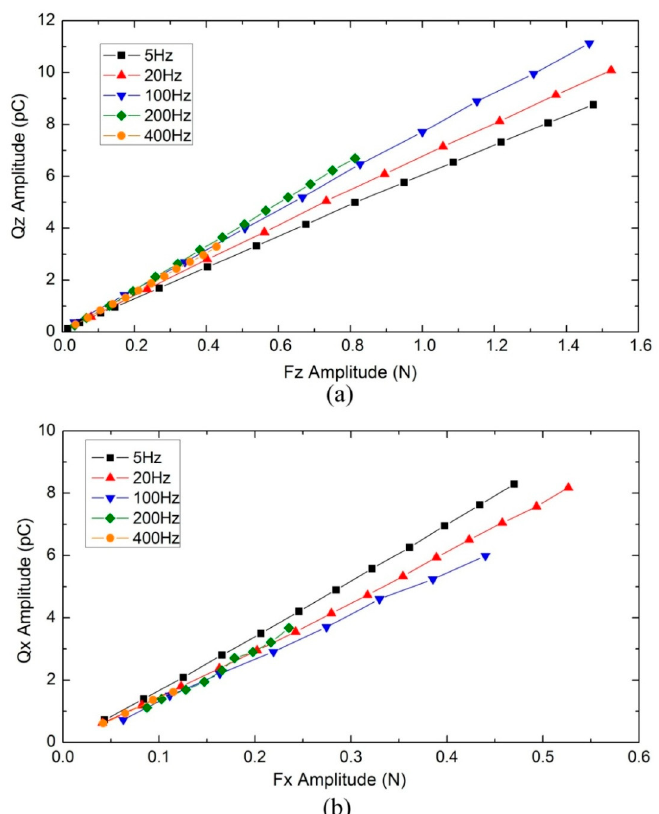
Figure 8. Frequency response of the tactile unit. ( a ) Average amplitude (100 wave periods) of sinusoidal output charge Q z versus sinusoidal input force F z at different frequencies; ( b ) average amplitude (100 wave periods) of sinusoidal output charge Q x versus sinusoidal input force F x at different frequencies.